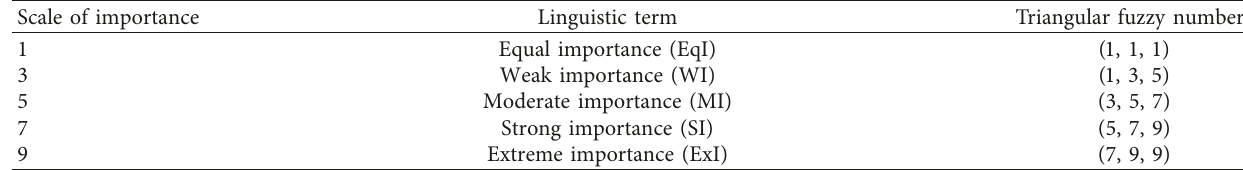
Table 2: The linguistic terms and the corresponding triangular fuzzy